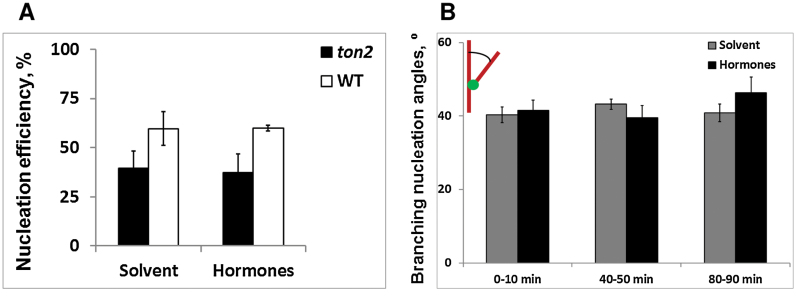
Nucleation efficiency and branching nucleation angles in hormone-treated cells. (A) MT nucleation efficiency from the recruited to the cell cortex γ-tubulin complexes. Nucleation efficiency calculated as a number of total nucleations (branching + parallel + de novo) divided by the sum of total nucleations and failed nucleation events. Failed nucleation events were scored as GCP2 complexes which did not promote nucleation during at least 6 s. n=4 cells per each case. (B) Branching nucleation angles. In both cases—without hormones and under hormones treatment—average branching nucleation angle stayed around 40°. The distribution of branching nucleation angles did not change significantly during the hormone induced microtubule reorientation (P>0.05, two-tailed Student’s T-test). For each time window 4 cells were analysed. Error bars show the standard deviation of the mean (SEM). (This figure is available in colour at JXB online.)